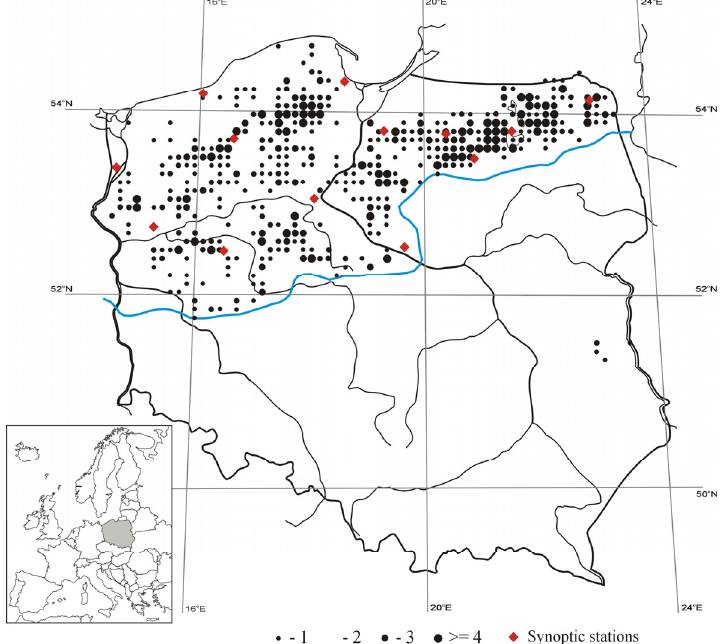
Figure 4. Location of the studied lakes and synoptic stations used in the research. The blue line marks the area of the last glaciation. 1–4 is the number of lakes in the square of the ATPOL geobotanical grid, cf. [66,67]. The conversion of geographic coordinates into ATPOL designations and Cartesian grid coordinates was made using the MS Excel calculator, which is available on the website of the Institute of Botany of the W. Szafer Institute of Botany of the Polish Academy of Sciences in Krakow (https: // botany.pl / atpol / ).